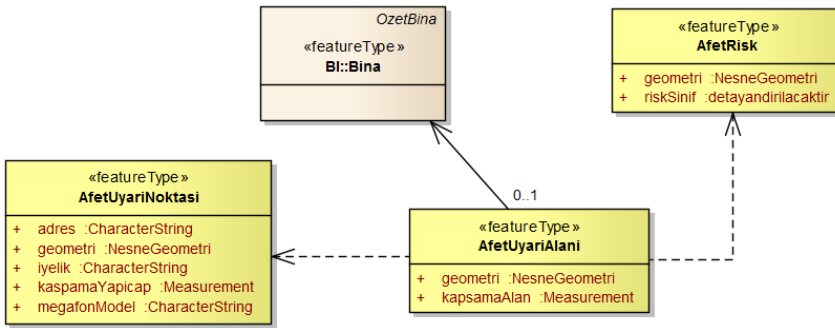
Figure 4. ADYS feature types concerning a disaster warning system.